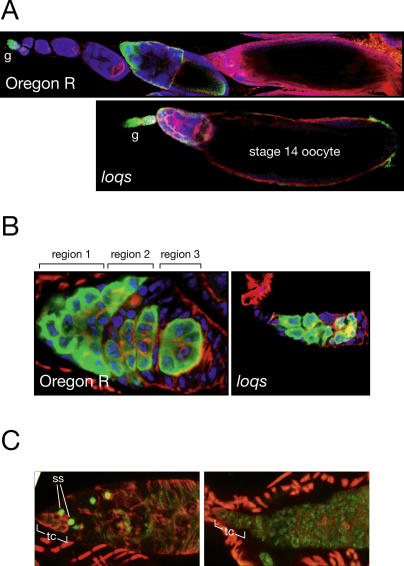
loqsf00791 Fail to Maintain Germ-Line Stem Cells(A) Wild-type ovarioles contain a germarium and a developmentally ordered array of six to eight egg chambers, whereas loqs
f00791 mutant ovarioles contain a smaller than normal germarium, two or three pre-vitellogenic egg chambers, and a late-stage egg chamber. Wild-type and loqs ovarioles are shown at the same magnification.(B) In wild-type ovarioles, the germarium contains several newly formed germ-line cysts surrounded by somatic follicle cells. In contrast, loqs
f00791 mutant germaria contain few germ-line cells, which are not organized into distinct cysts. The follicle cell layer is also significantly reduced inloqs
f00791 germaria.(C) Wild-type and loqs mutant germaria labeled for α-Spectrin (green) and filamentous Actin (red). In wild type, anti-α-Spectrin labels the spectrosome (ss), a structure characteristic of germ-line stem cells, which are normally found at the anterior of the germarium, apposed to the somatic terminal cells (tc). The cystoblasts, the daughters of the stem cells, also contain a spectrosome, but are located posterior to the stem cells. In loqs mutant ovaries, spectrosome-containing cells were not detected, indicating that normal germ-line stem cells are not present. These observations indicate that stem cells are not maintained.In (A) and (B), ovaries were labeled for filamentous actin (red) using rhodamine phalloidin, DNA (blue) using TOTO3 (Molecular Probes), and the germ-line marker Vasa (green) using rabbit anti-Vasa antibody detected with fluorescein-conjugated anti-rabbit secondary antibody. In (B) and (C), wild-type and loqs germaria are shown at the same magnification.